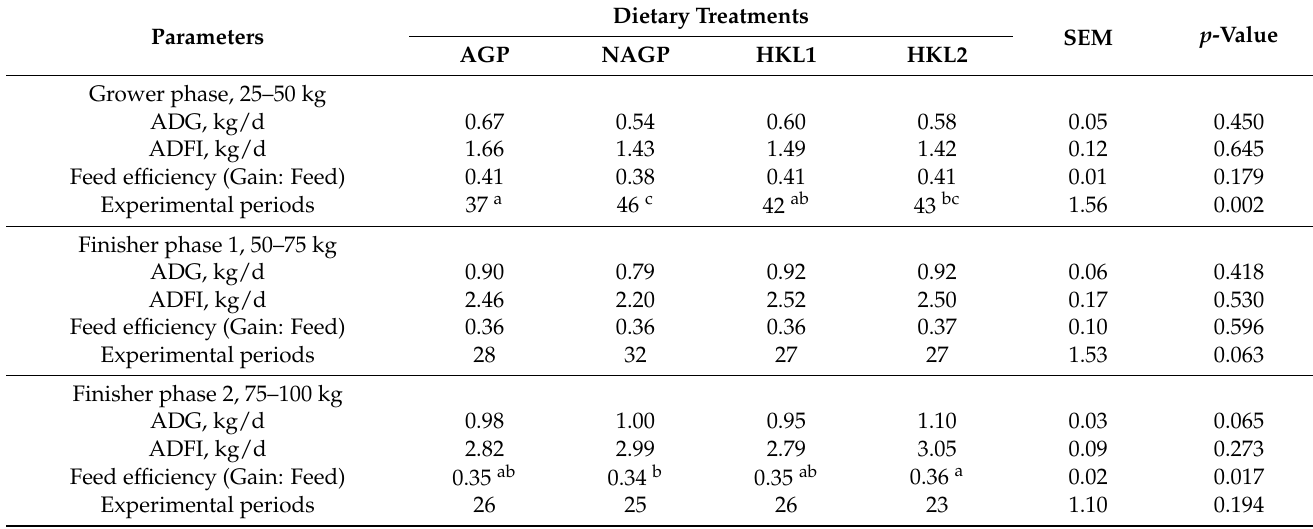
Table 5. Effects of the dietary treatments on the growth performances of the pigs from the starter to the finisher phases to reach 100 kg in body